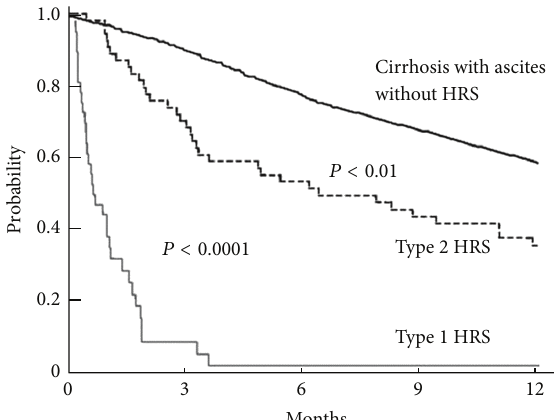
Figure 2: Probability of survival in cirrhotic patients with different types of renal impairment: nonazotemic patients (bold continuous line), type 2 HRS (dotted line), and type 1 HRS (continuous line) (reproduced with permission from “BMJ Publishing Group Limited,” Salerno et al.